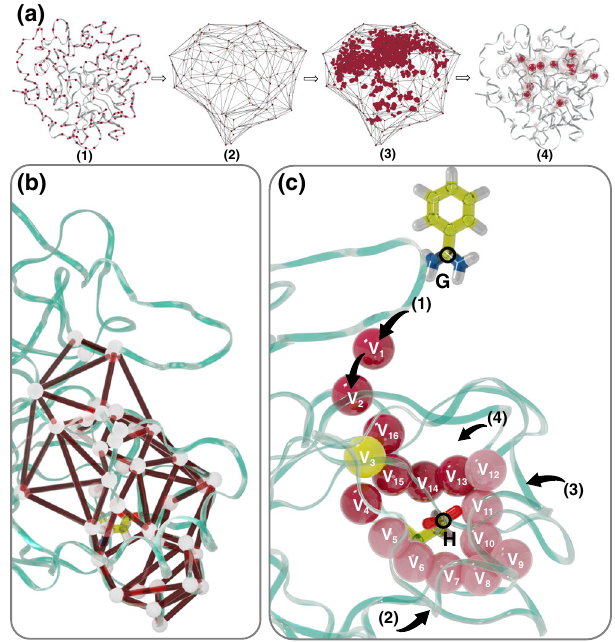
Fig. 2 | Identi fi cation of long-lived water molecules. a Graphical representation of the four steps strategy used to identify the long-lived hydration spots. (1) α - Carbon atoms of the residues located on a protein's outer surface, represented by red dots. (2) Convex hull surface built from the α -Carbon atoms shown in (1). (3) Distributionofthelong-livedwatermoleculesinsidethesurface.(4)Centersofthe waterdistributionfromstep(3)obtainedwithaclusteringalgorithm. b Convexhull surface built around the binding pose of Trypsin. c Position of the 16 hydration spots V i , shown by spheres. The hydration spots V 5 − V 12 coincide with the position of the reservoir water molecules of ref. 14 and the dark red spheres lie on the binding path. The yellow sphere on V 3 shows the position of the key W1 water molecule 14 that forms a hydrogen bond with the ligand. Black arrows indicate the four possible paths of entrance/exit for water molecules in the binding pocket.